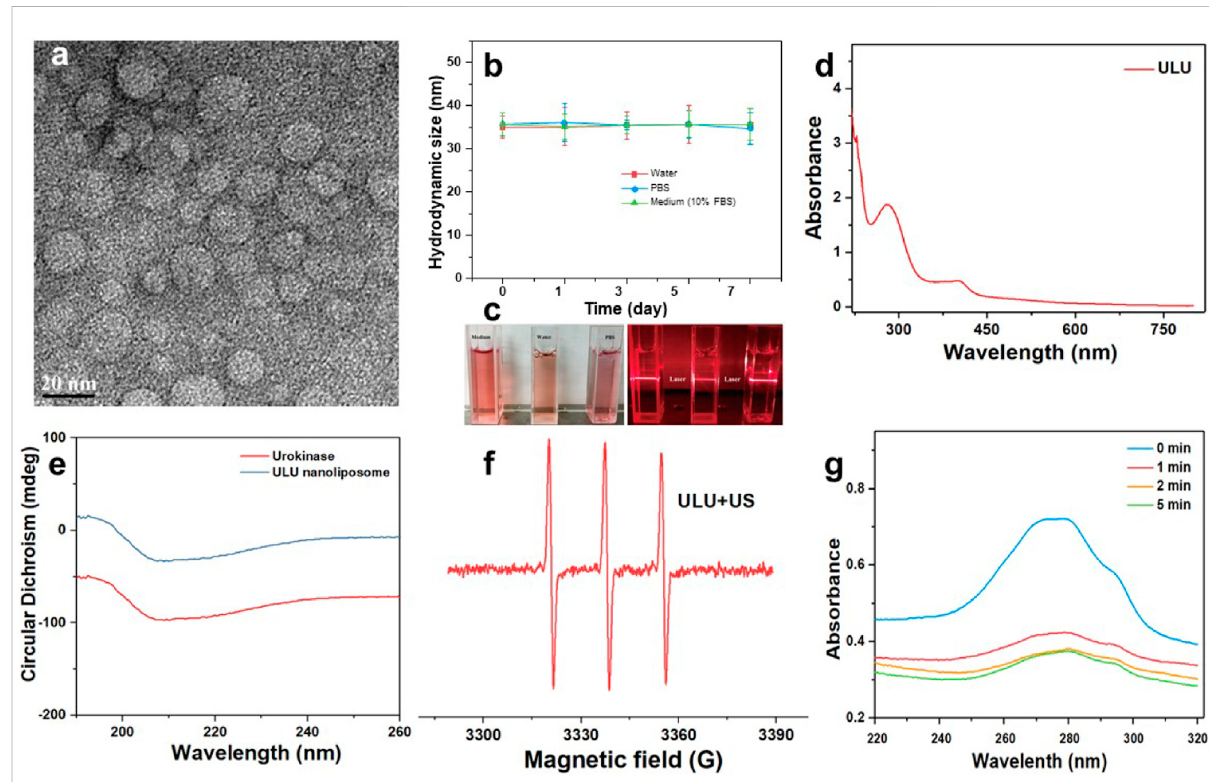
FIGURE 1 Transmission electron microscopy of ULU nanoliposome (A) , the hydrated particle size change (B) , and digital photographs (C) of colloidal stabilityofULUnanoliposomedispersedinwater,PBS,andcellculturemedium(added10%FBS)within7 days;theUV-VisabsorptionspectraofULU nanoliposome (D) ; Circular dichroism chromatogram of urokinase and the prepared ULU nanoliposome (E) ; ESR spectra of ULU nanoliposome with theultrasonicirradiation(1.0 W/cm 2 ,5min, (F) ;UV-Visabsorption spectraofurokinase-containingnanoliposome(ULU)atdifferenttimepoints after ultrasonic stimulation at 1.0 W/cm 2 , 5 min (G) .